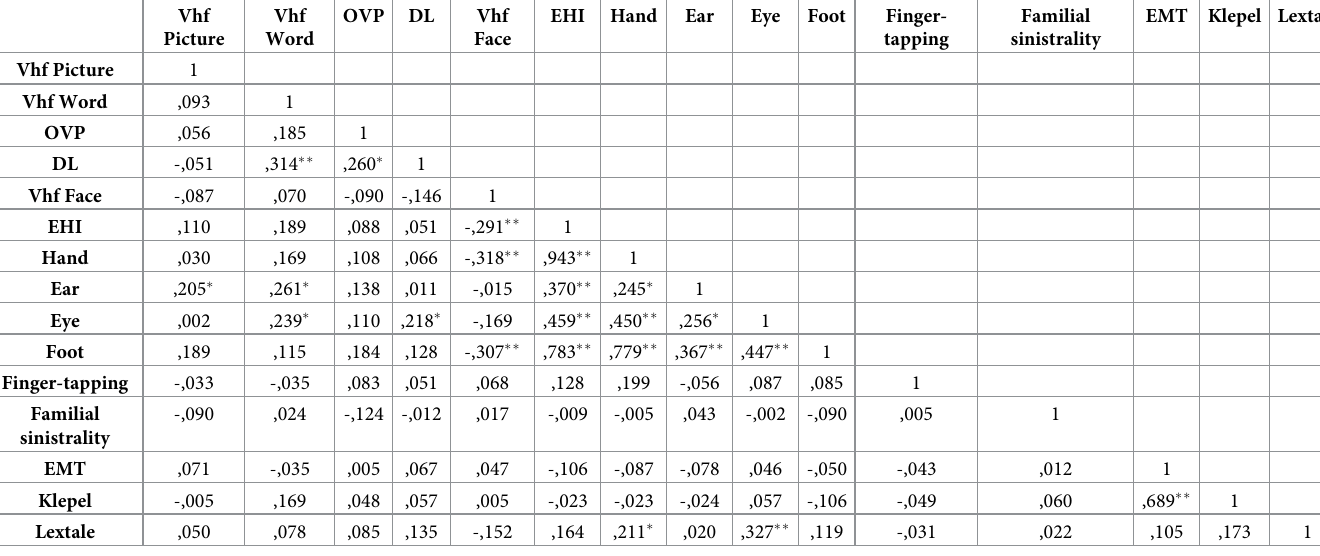
VHF = visual half field: DL = dichotic listening; OVP = Optimal Viewing Position; EHI = Edinburgh Handedness Inventory; EMT = One-minute-test. �� denote significant correlations at the 0.01 level (2-tailed) � denote significant correlations at the 0.05 level